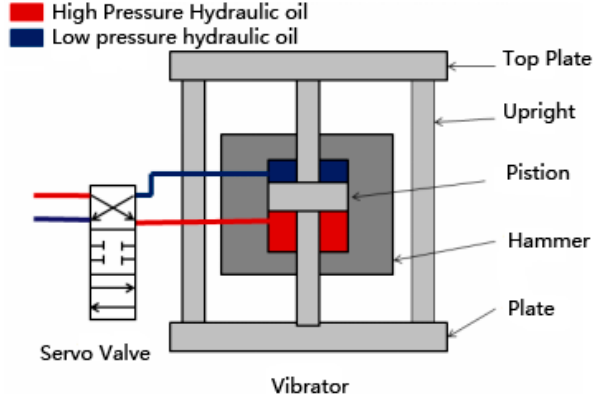
Figure 2. The working principle of a vibrator.